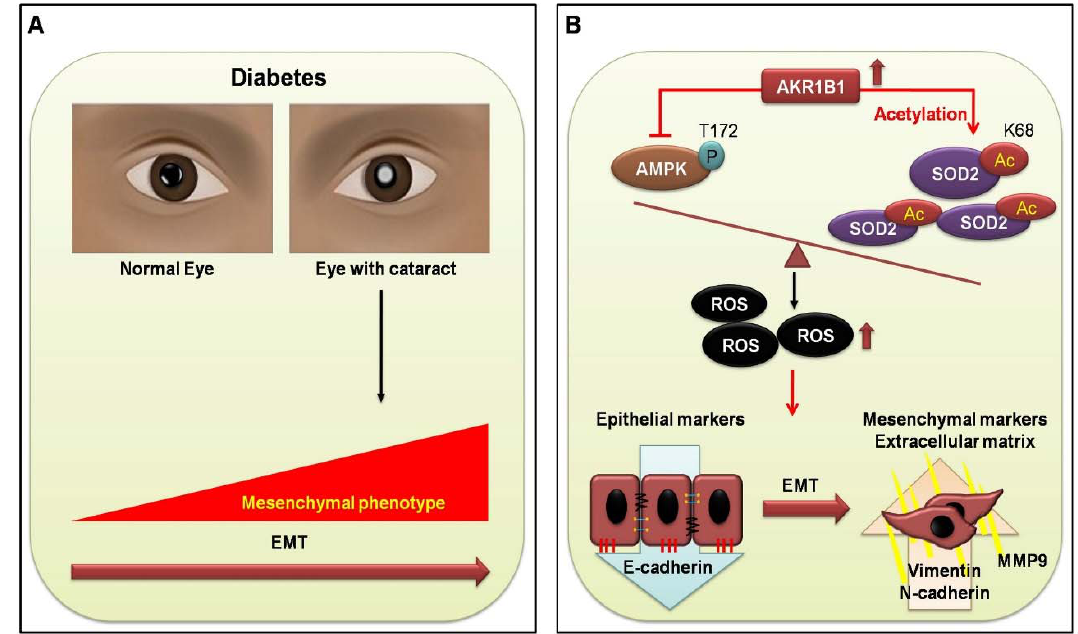
Figure 5. Proposed signal transduction cascades in DM ( + ) and DM ( − ) cataract patients. ( A ) Current evidence supports the view that cataracts are a major cause of visual acuity deterioration in DM; however, that relationship is still unclear. In the present study of diabetic eye disease, we hypothesize that EMT in DM cataracts occurs through AKR1B1-enhanced advanced glycation end products (AGE), and ROS generation influences the cataract development in DM. ( B ) AKR1B1 overexpression inhibited AMPK activation, thereby increasing AcSOD2 and ROS-induced EMT in the lens epithelial cells LECs of diabetic cataracts. This suggests a potentially important mechanism for the pathogenesis of diabetic cataracts.